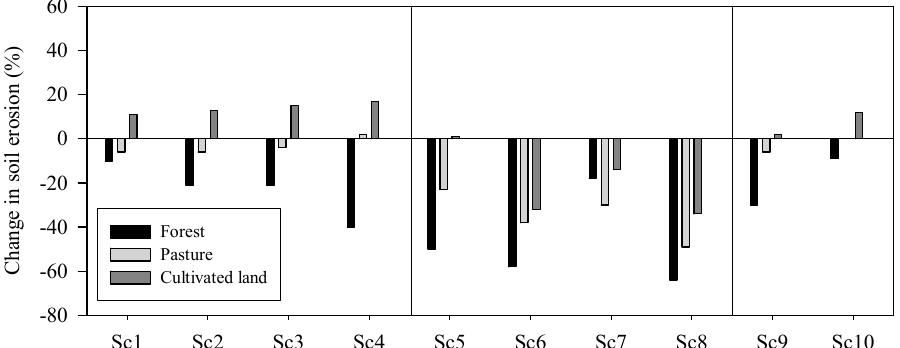
Figure 5. Response of erosion of different vegetation covers to changes in temperature (Sc1, Sc2, Sc3 and Sc4), rainfall (Sc5, Sc6, Sc7 and Sc8) and CO 2 concentration (Sc9, Sc10) based on the scenarios defined. Sc1: T + mean 2031–2060 °C; Sc2: T + max 2031–2060 °C; Sc3: T + mean 2069–2098 °C; Sc4: T + max 2069–2098 °C; Sc5: P–mean 2031%–2060%; Sc6: P–max 2031%–2060%; Sc7: P–mean 2069%–2098%; Sc8: P–max 2069%–2098%; Sc9: 1.5 × CO 2 ; Sc10: 2 × CO 2 .